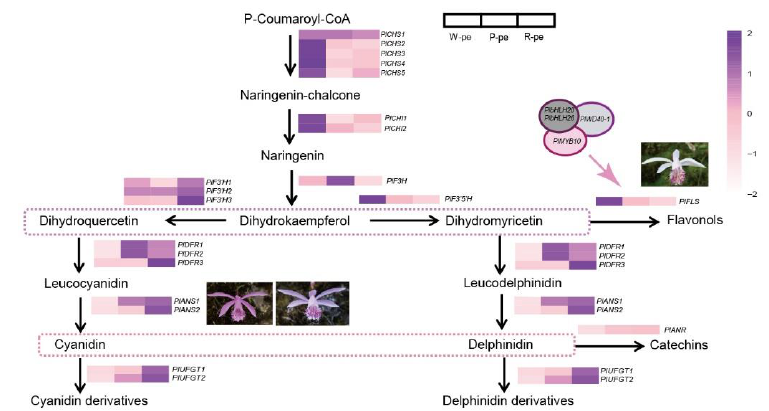
Figure 9. Tentative pathways for P. limprichtii color variations. The colored bar is the value of log2 (RPKM + 1), represented using the depth of color, with purple representing the up-regulated expression genes and pink representing the down-regulated expression genes. RPKM means the reads per kb per million reads mapped. CHS, chalcone synthase; CHI, chalcone-flavanone isomerase; F3H, flavanone-3-hydroxylase; F3’H, flavonoid 3’-hydroxylase; F3’5’H, flavonoid 3’5’-hydroxyla; DFR, dihydroflavonols 4-reductase; ANS, anthocyanidin synthase; UFGT, UDP flavonoid glucosyl transferase; FLS, flavonol synthase; The three gene complex consist of a MYB, bHLH and WD40 in most